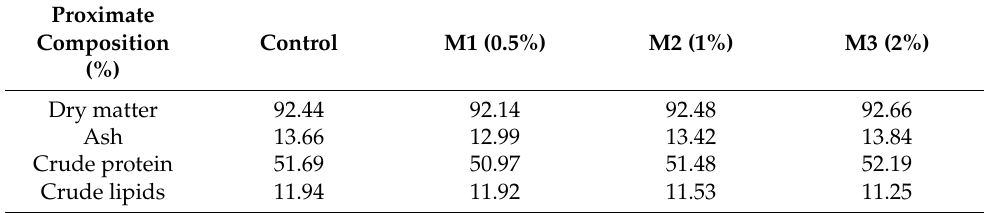
Table 1. Proximate composition of experimental diets including different levels of O. vulgare